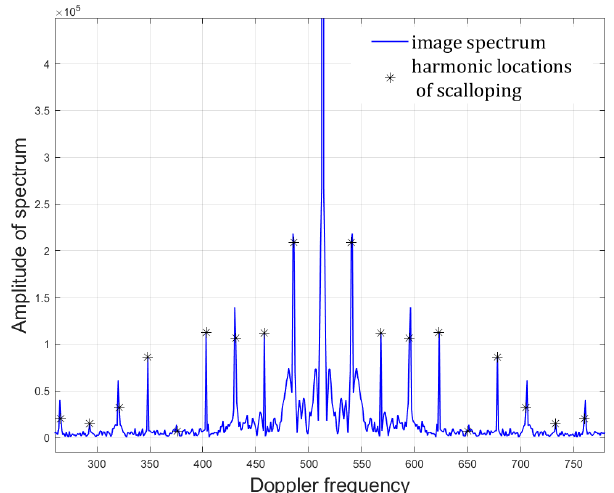
Figure 7. The harmonics caused by scalloping in uniform scene.